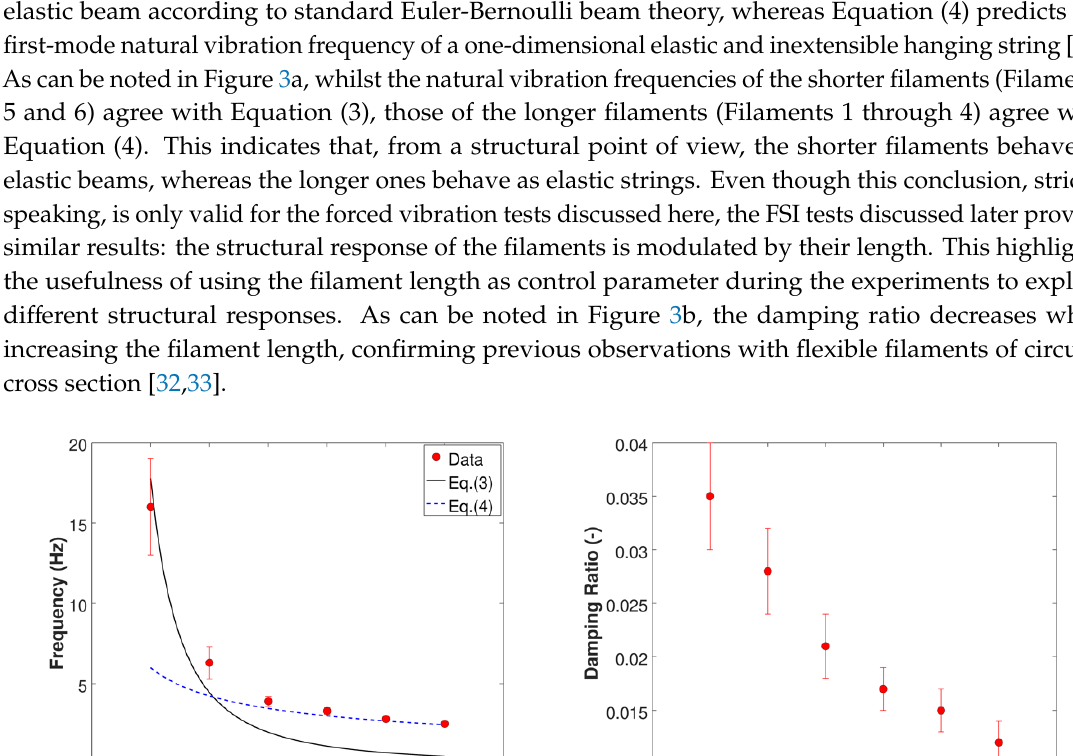
Table 2. Flexible filaments used in the present FSI experiments.